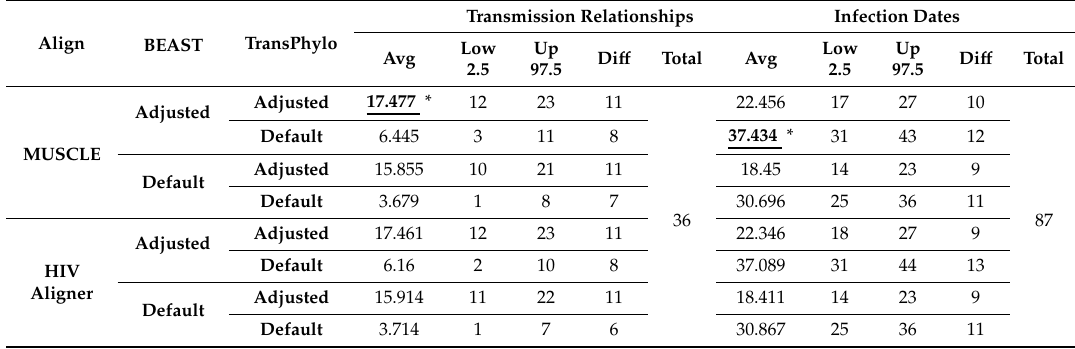
Table 4. The average of accurately inferred person-to-person (P2P) transmission relationships and infection dates in selected transmission trees generated by each combination of parameters for each program over 1000 replications at their 95%